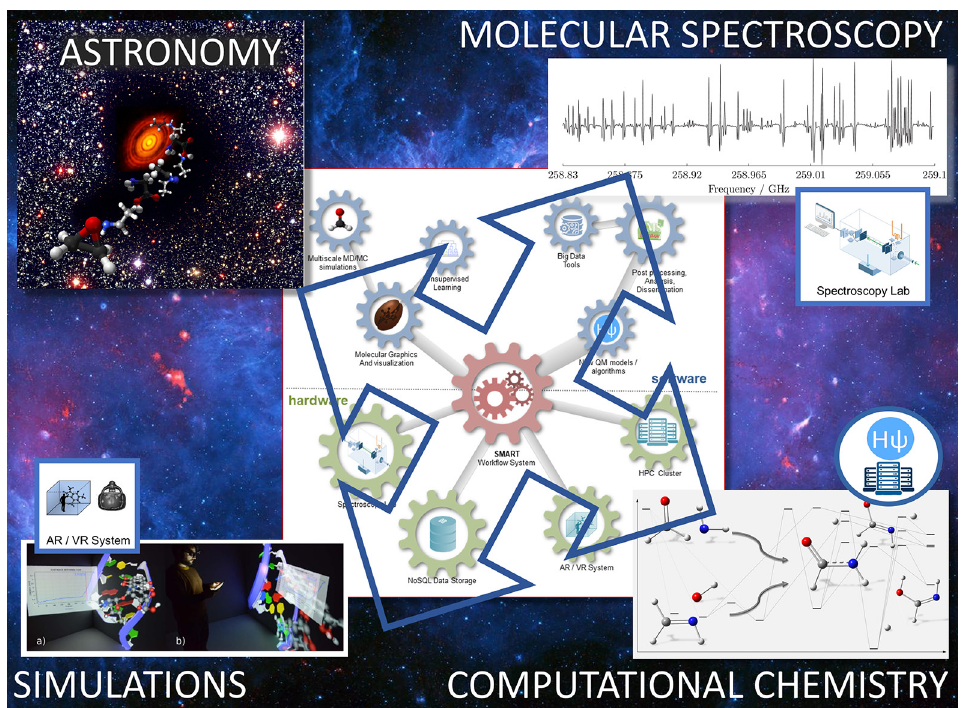
Fig. 5. – Integration of different aspects in astrochemistry: the “four-pillar approach”.